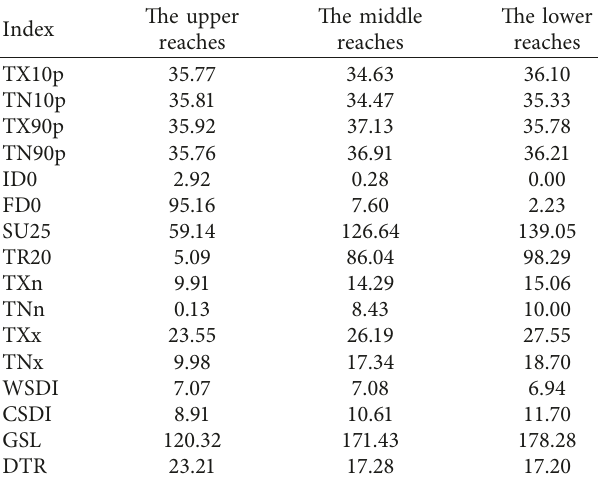
Table 2: Mean extreme temperatures in the upper, middle, and lower reaches of the Minjiang River Basin from 1961 to 2016 ( ° C or days).